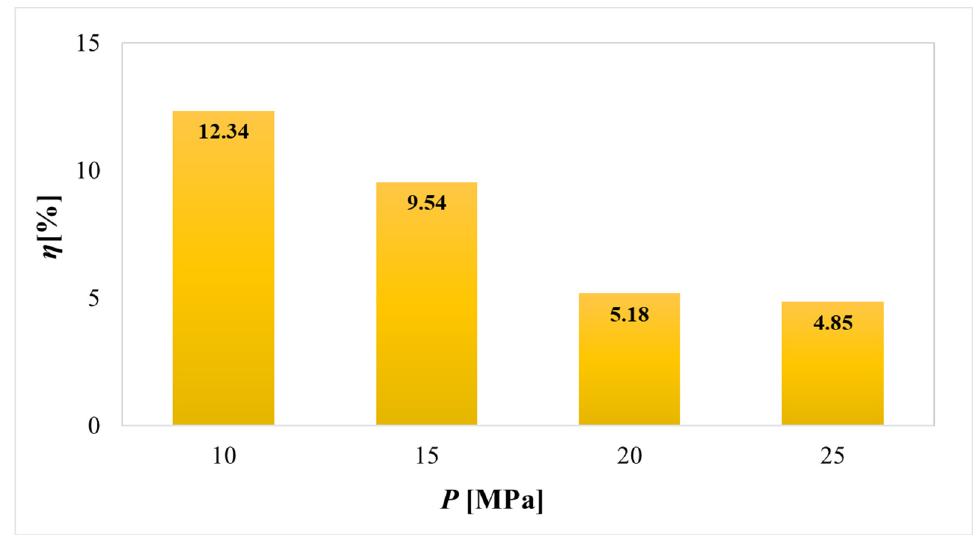
Figure 3. Extraction yields ( η ) obtained by supercritical fluid extraction (SFE) of lyophilized PP using CO 2 and EtOH as co-solvent at different pressures.